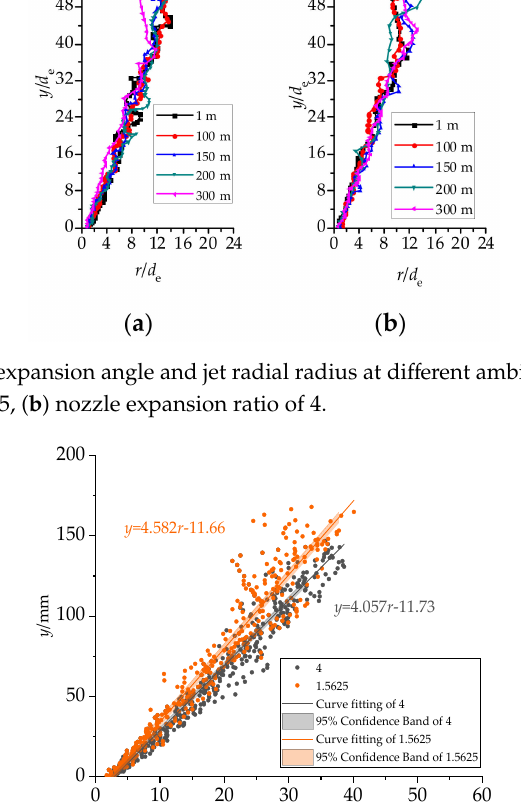
Figure 13. Revolution of the gas-water interface.